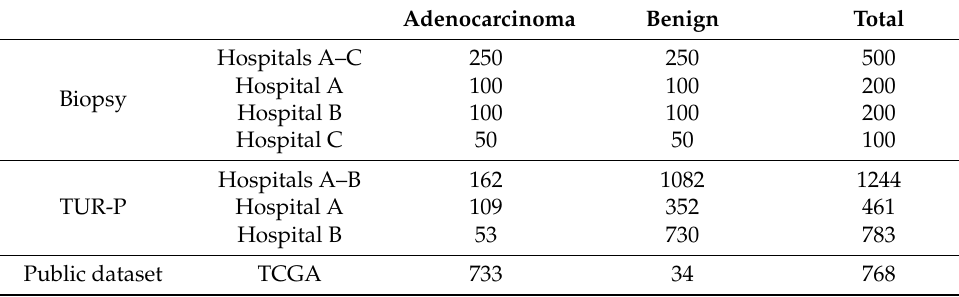
Table 2. Distribution of the WSIs in the test